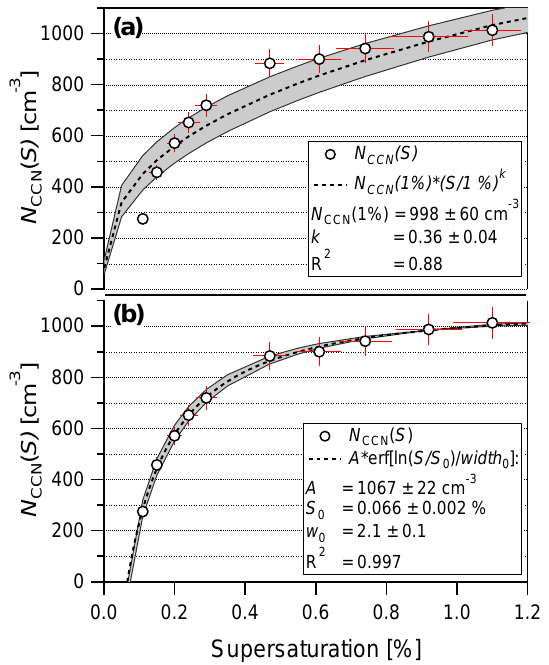
Figure 10. CCN spectrum (circular markers) averaged over the entire measurement period and fitted with the classical Twomey power-law fit (a) and an alternative error function fit (b) . Error bars at the markers represent the measurement error in S and standard er- ror in N CCN ( S ). The dashed line is a fit function with grey shading as uncertainty of the fit.